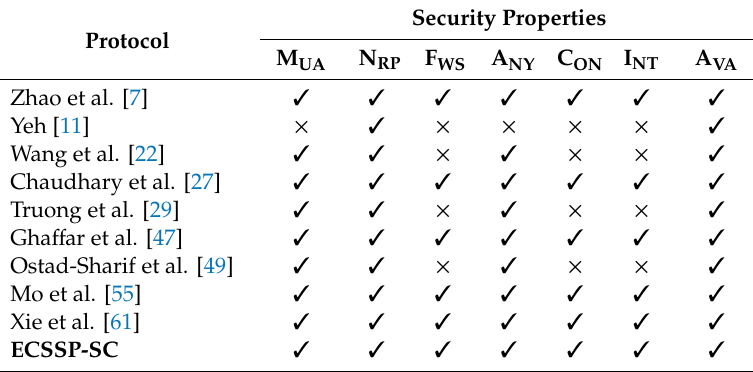
Table 5. Security attributes of di ff erent smart card security protocols.